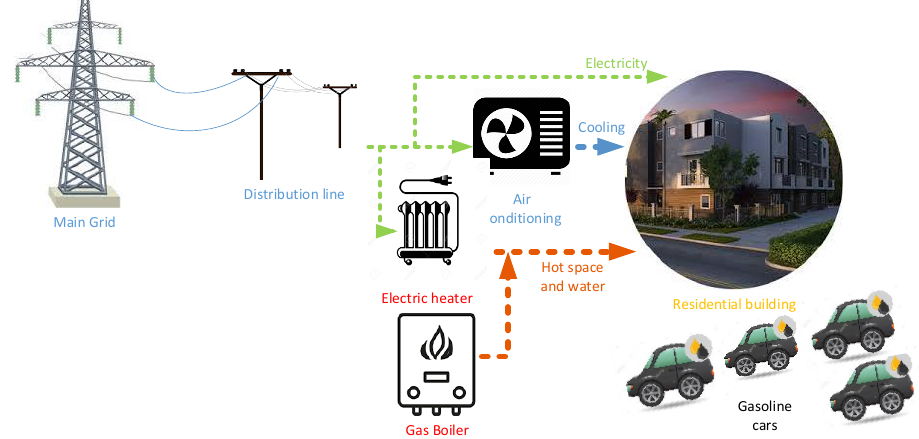
Figure 1. Conventional energy system design for residential application .